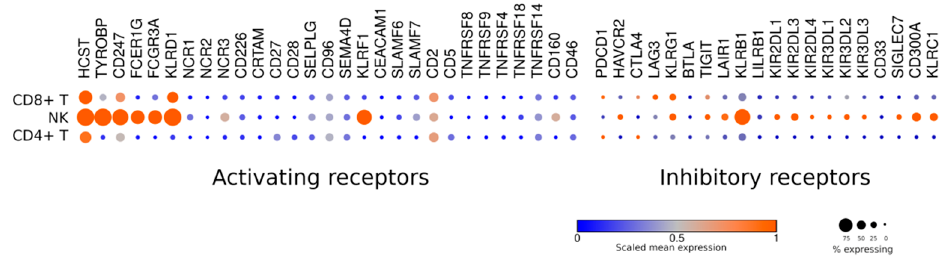
Figure 2. NK cells express a wide variety of activating and inhibitory